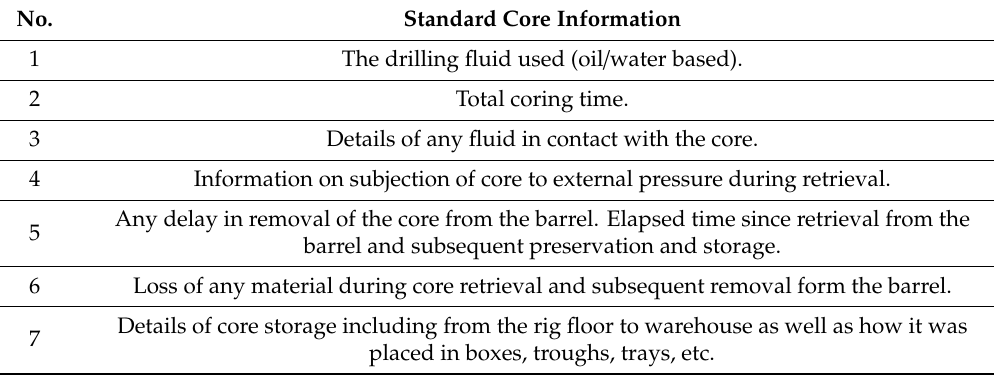
Figure 1. Thin sections of a gas shale retrieved from a depth of 3994 m belonging to a core from the Bossier–Haynesville formation of East Texas Basin of Jurassic age (156 to 145.5 Ma). Corresponding magnification of ( A ) 50× and ( B ) 200×. Abundance of recrystallized, undifferentiated calcite particles (stained pink with Alizarin Red in the micrographs. Quartz (Q: white) present but not abundant. The matrix consists of recrystallized calcite and amorphous organics (opaque). Near vertical fracture (VF) is infilled with carbonate cement. Table 2. The essential background information required for any core to be used for scientific